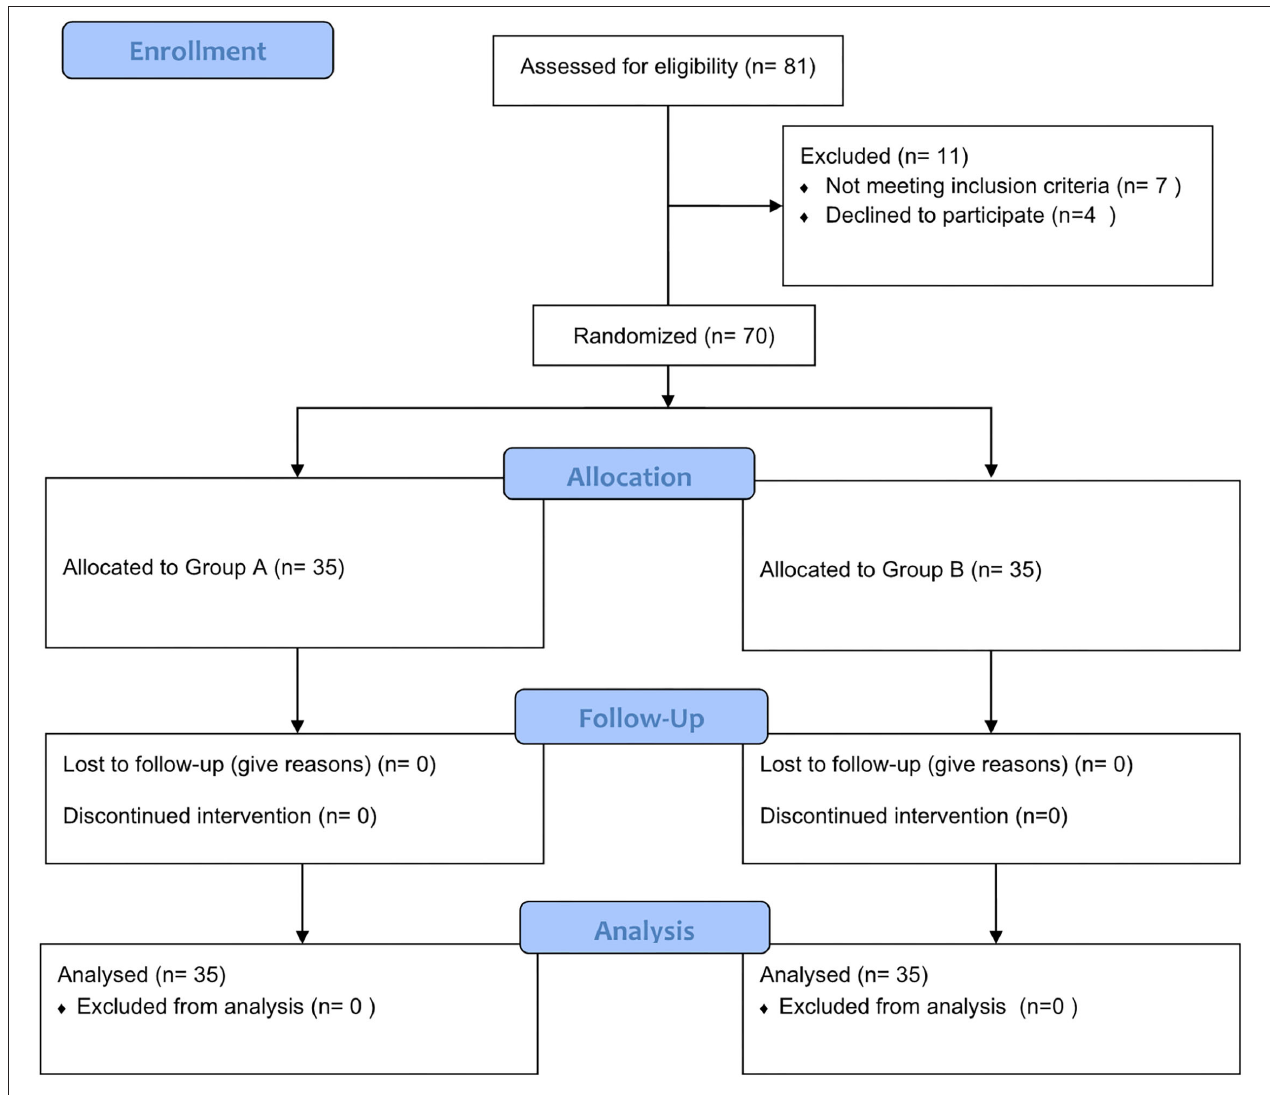
FIGURE 1 | Flowchart for the study recruitment.